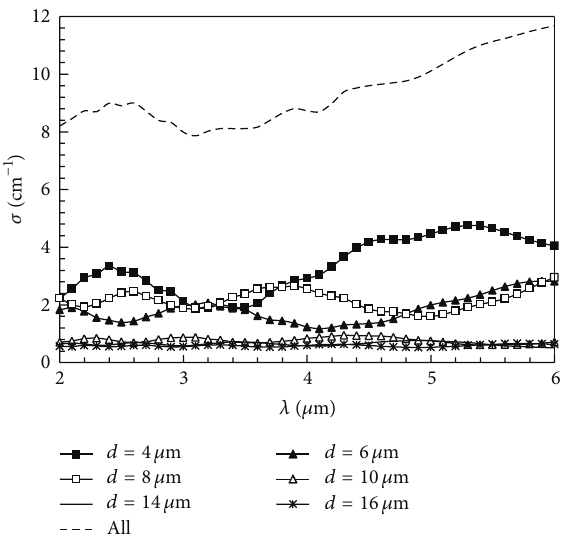
Figure 7: Calculated scattering coefficient of Al 2 O 3 particles with Mie model.